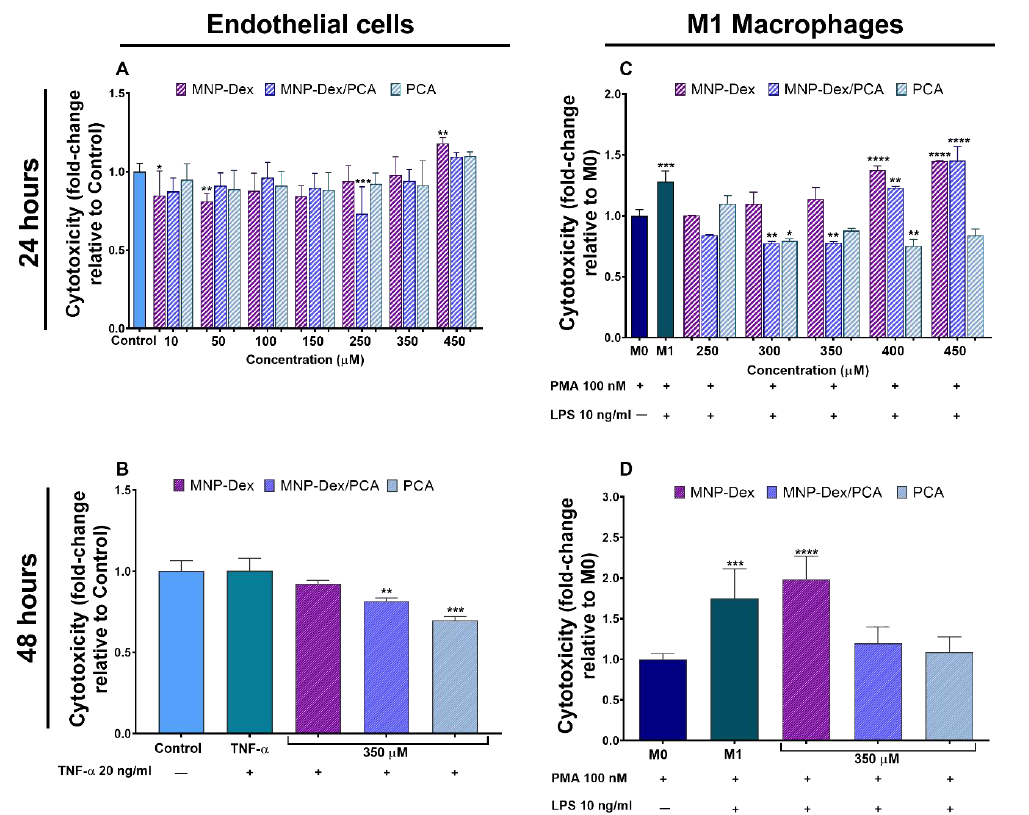
Figure 2. Cell cytotoxicity after 24 h of incubation with increasing concentrations of MNP-Dex, MNP-Dex/PCA, and PCA on human endothelial cells ( A ) and M1 type macrophages ( C ), and after 48 h of incubation of human endothelial cells in the absence (-) or the presence (+) of TNF- α ( B ) and M1 macrophages ( D ) with the chosen pharmacologically relevant concentration of PCA (350 µ M) loaded on MNP (MNP-Dex/PCA), plain MNP-Dex, and free PCA. * p < 0.05, ** p < 0.01, *** p < 0.001, and **** p < 0.0001 vs. control cells (EC or M0 macrophages cultured in the absence of any